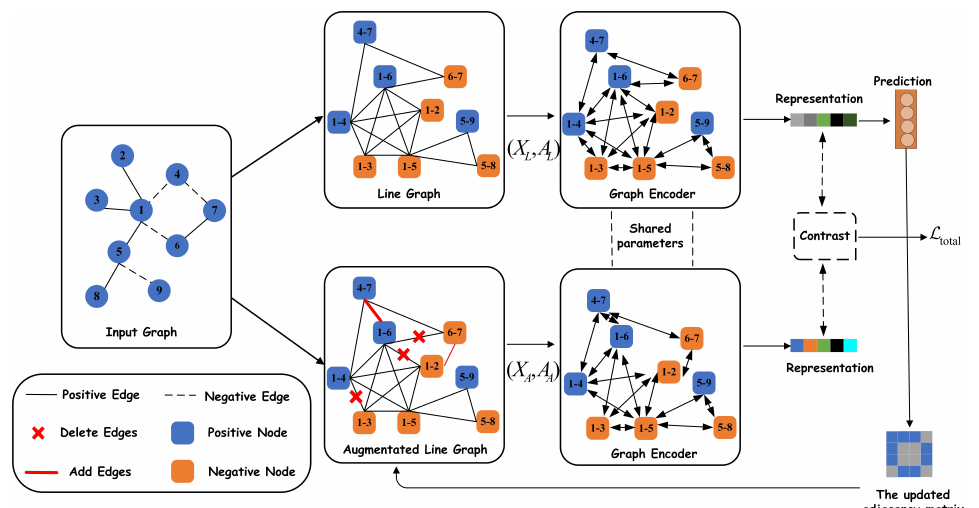
Figure 1. Overview of the ALGC. After converting the graph to a line graph, we adopt the pre- diction results to adjust the number of intra- and inter-class edges in the line graph to produce a new augmented line graph, and finally, we use contrastive learning to balance the information in both